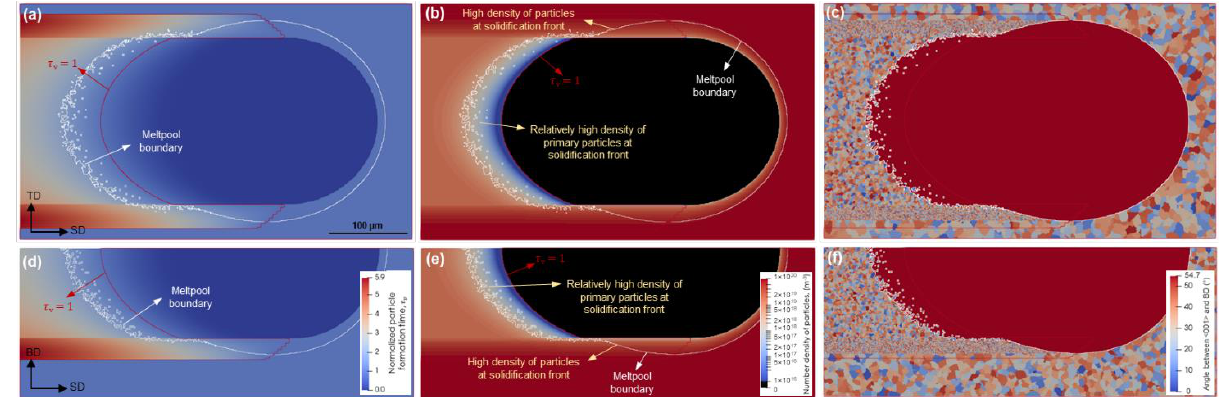
Figure 10. CA simulations of particle and microstructure evolution at a scanning speed of 500 mm/s and a platform temperature of 473 K; distributions of normalized particle formation time τ v ( a , d ), particle number density ( b , e ), and resulting grain structure ( c , f ) on the top surface ( a – c ) and the longitudinal cross-section ( d – f ).